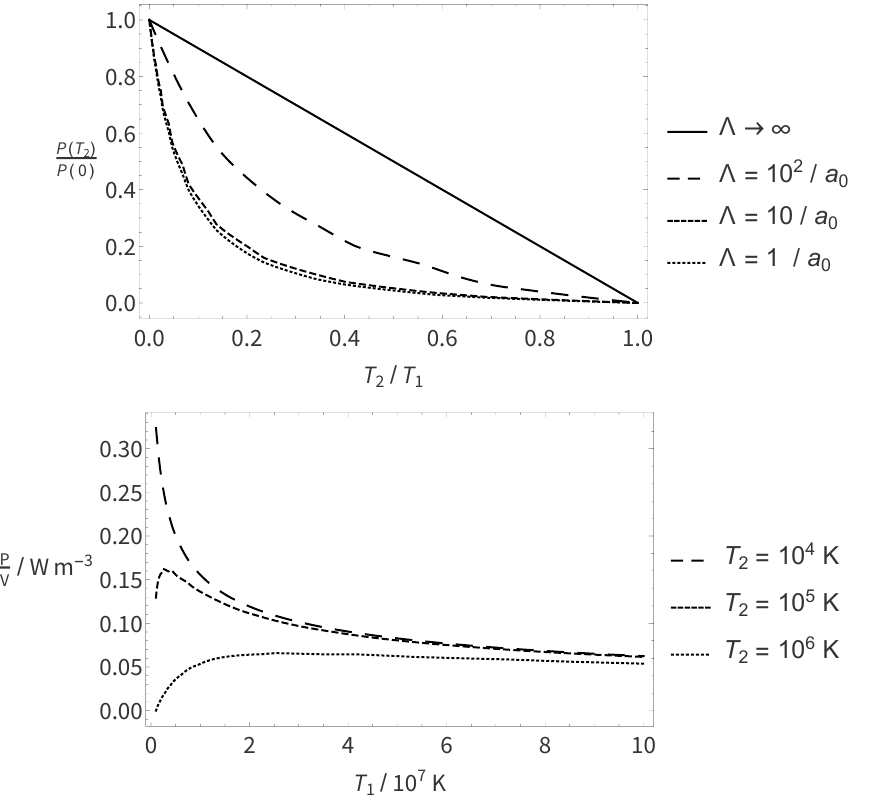
Figure 4 . Top: heating rate from hot gas 1 to colder gas 2 via (cid:15) 2 -suppressed photon exchange, as a function of T , normalised to unity at T = 0 . We show the dependence for different values of 2 /T 1 2 the inverse screening length Λ , which appears in the scattering cross section (5.3). The solid line is the familiar contact interaction limit in which the heating rate is proportional ∆ T . The amount by which the heating rate departs from this behaviour is characterised by the dimensionless parameter √ µT 1 / Λ , where µ is the reduced mass. For this plot we chose T 1 = 2 . 9 × 10 6 K, m 1 = 10 GeV and √ m 2 = 1 GeV, and a 0 is the usual Bohr radius of the hydrogen atom, so that µT 1 / Λ = 130 , 13 , 1 . 3 for the three curves from bottom to top. Bottom: heating rate per unit volume as a function of T 1 , the temperature of the hotter gas. This is to illustrate the unfamiliar behaviour that a hotter gas can actually be less efficient at heating than a cooler gas, if the interaction is mediated by (cid:15) 2 - suppressed massless vector exchange. For this plot we chose m = 10 GeV, m = 1 GeV, Λ = 1 /a , 1 2 0 and took the density of both species to be 10 26 m − 3 (the overall heating rate is just proportional to n 1 n 2